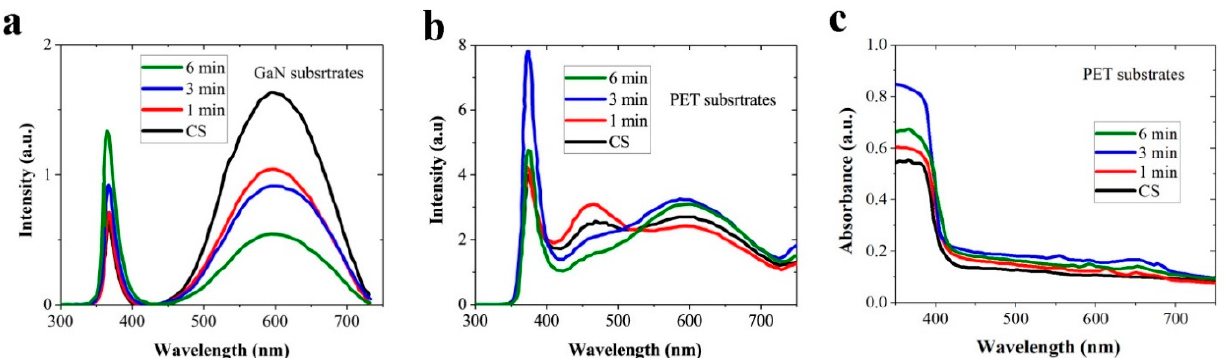
Figure 6. Room temperature PL spectra of ZnO NRs with as-grown SLs (CS) and the SLs N 2 O plasma-treated for 1, 3, and 6 min in the cases of growths on ( a ) the GaN and ( b ) PET substrates. ( c ) UV/visible spectra of the NRs measured at room temperature.